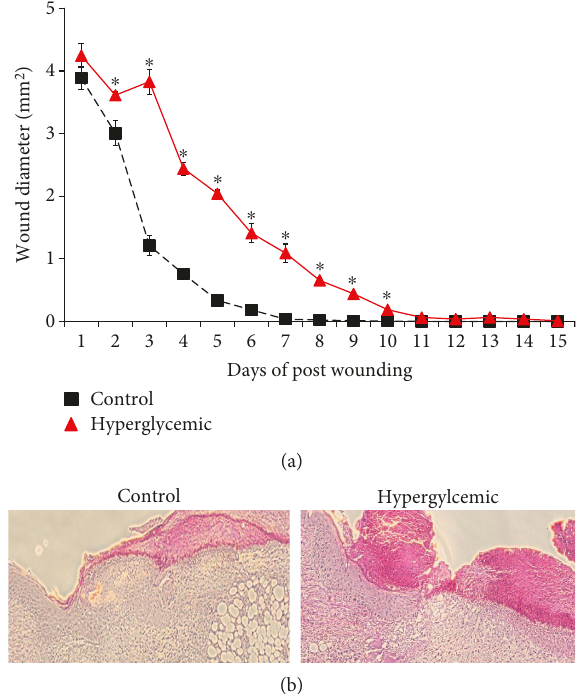
Figure 1: Delayed wound closure in hyperglycemic mice. Four- to six-week-old male C57BL/6 mice were treated with STZ once per day for 5 days to initiate diabetic hyperglycemia. Six weeks of postinduction, four 4mm diameter full-thickness wounds were produced and photographed daily for 15 days. (a) Wound images were analyzed and wound diameter determined via ImageJ. Data are expressed as means ± SE ( n = 10 ). ∗ Signi fi cantly di ff erent ( p < 0 05 ) from euglycemic C57 (control) mice. (b) On day three postwounding, wounds were collected and hematoxylin/eosin- stained sections were assessed for di ff erences in wound healing using a Leica DM400B microscope at 100x magni fi cation. Slides shown are representative of ten samples per treatment